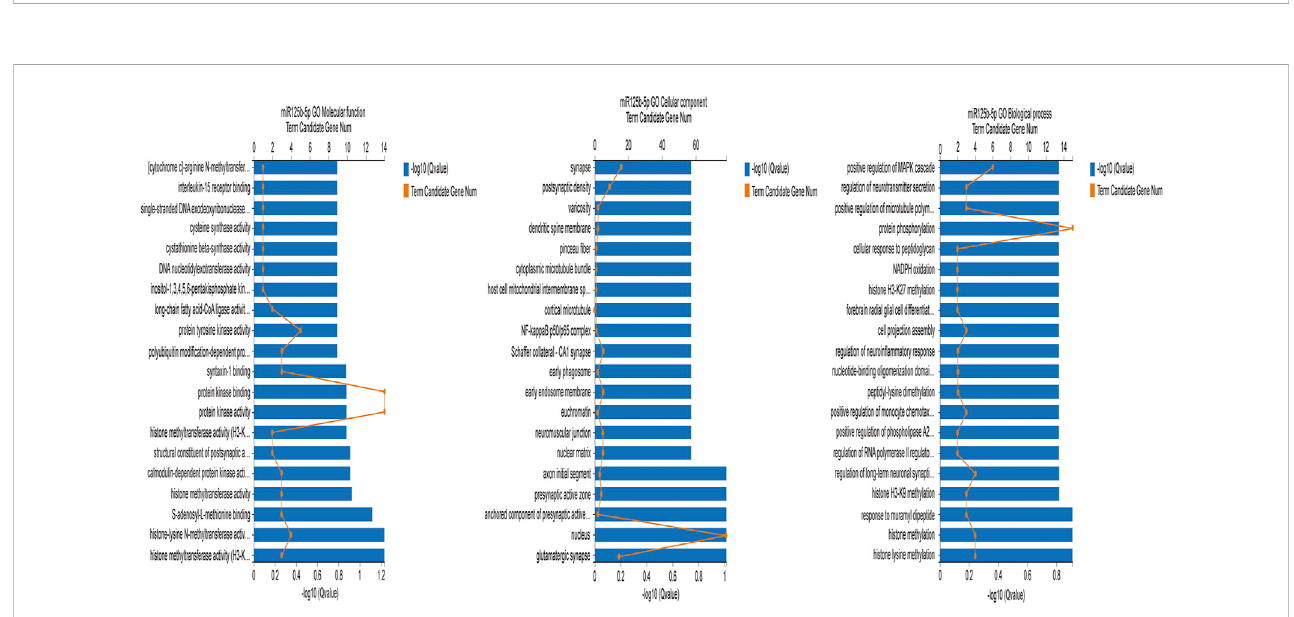
FIGURE 7 GO functional classi fi cation of differentially expressed rno-miR125b-5p target genes.